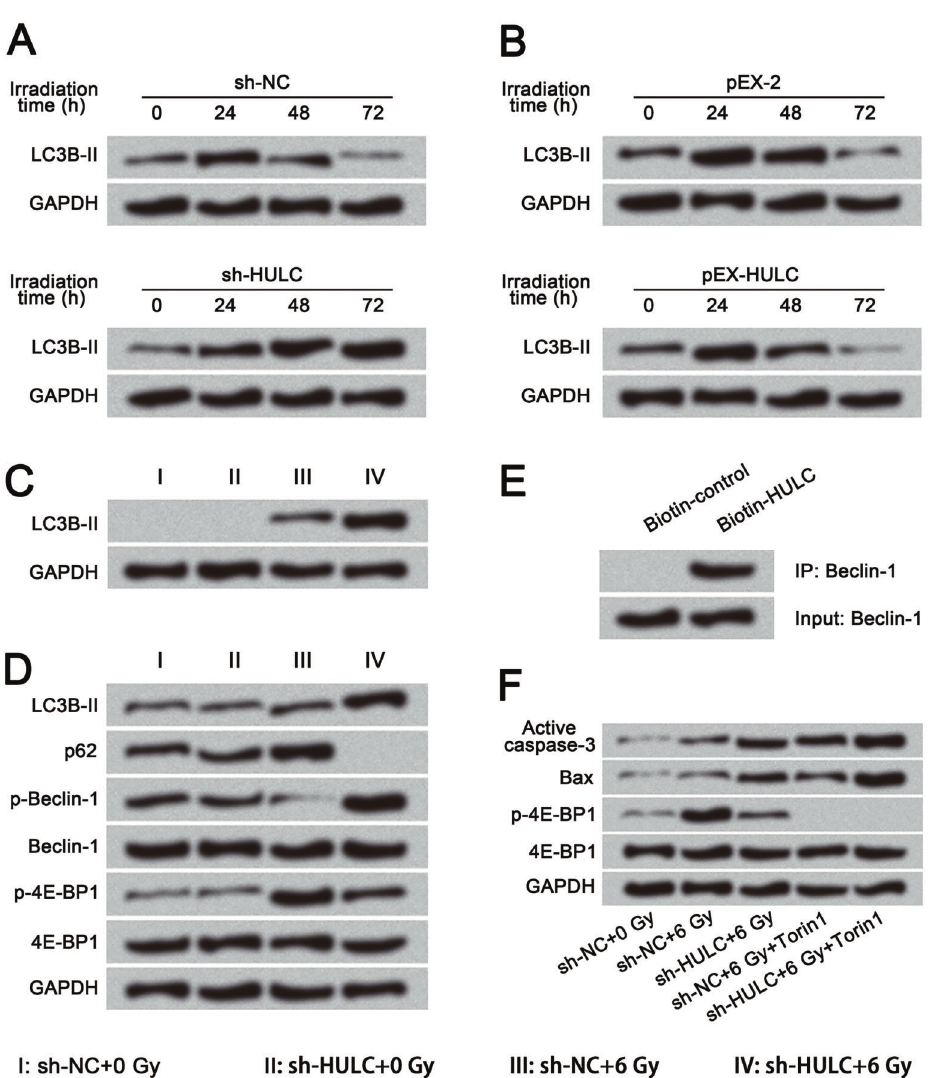
from HULC silenced-PC3 cells was higher than the sh-NC group after irradiation. D, HULC knockdown promoted autophagy through suppressing the mTOR cascade. E , HULC bound to Beclin-1. F , The effect of HULC knockdown on PC3 cells was further augmented by mTOR inhibitor. HULC: long non-coding RNA highly upregulated in liver cancer; sh-HULC: pGPU6/GFP/Neo plasmid carrying short- hairpin RNA targeting HULC; sh-NC: pGPU6/GFP/Neo plasmid carrying a non-targeting RNA; pEX-HULC: pEX-2 plasmid carrying full- length HULC; LC3B-II: microtubule-associated protein 1 light chain 3B II; 4E-BP1: eukaryotic initiation factor 4E binding protein 1; p: